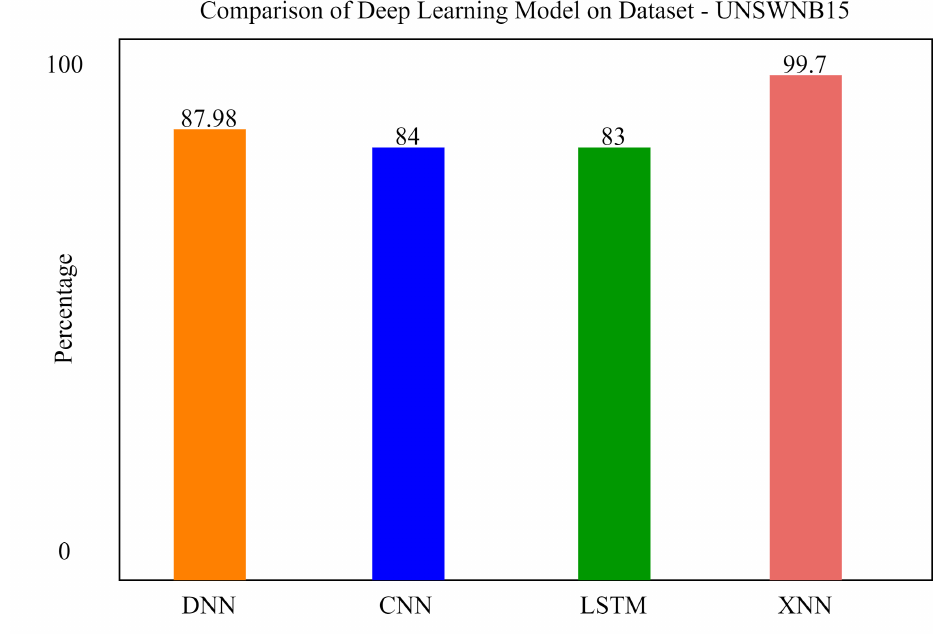
Figure 12. Comparison of deep-learning models for the classification of attacks in